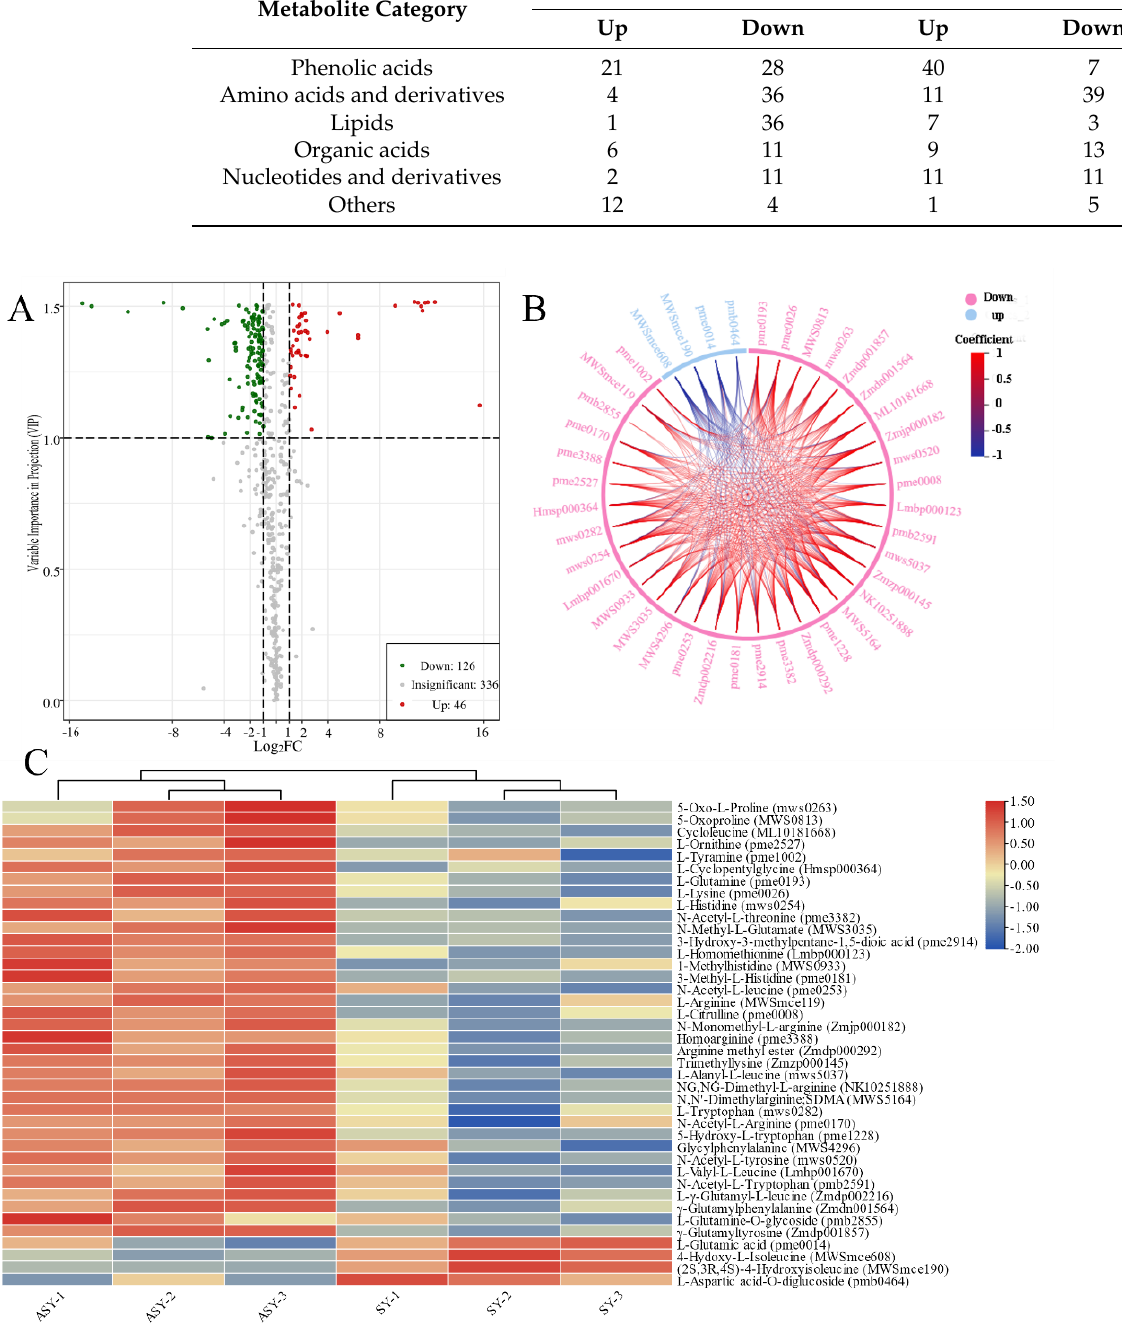
Figure 5. The selection of different metabolites and comparison of amino acids and derivatives between ASY and SY phenotypes of F. cirrhosa . ( A ) The volcano plot; ( B ) chord diagram of differential amino acids metabolites, which full names are the same as those of heatmap; ( C ) heatmap of amino acids metabolites. ASY: aberrant six-year samples. SY: six-year samples.